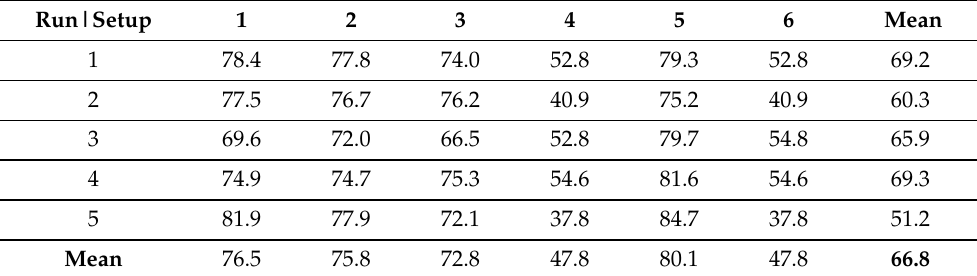
Table 13. Weighted F1-score results on long sentences for six different dataset setup and five runs.